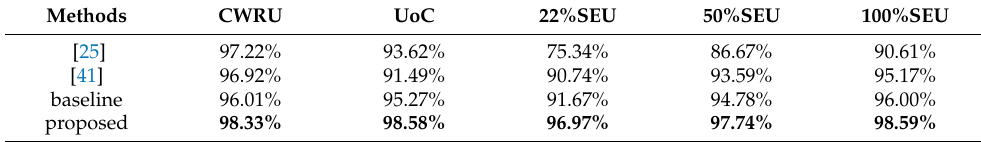
Table 14. Test accuracies of different methods on datasets with noise plus trend items.